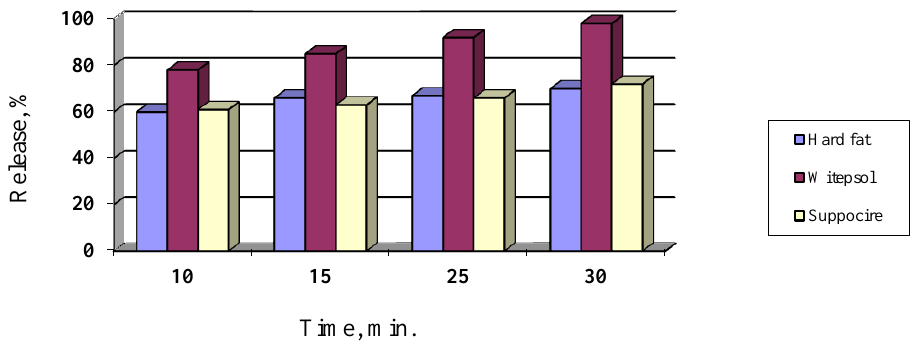
Fig. 1. The influence of suppository base on Acyclovir release from the